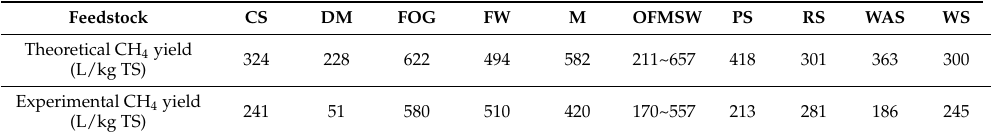
Table 1. Biogas yield for different feedstocks